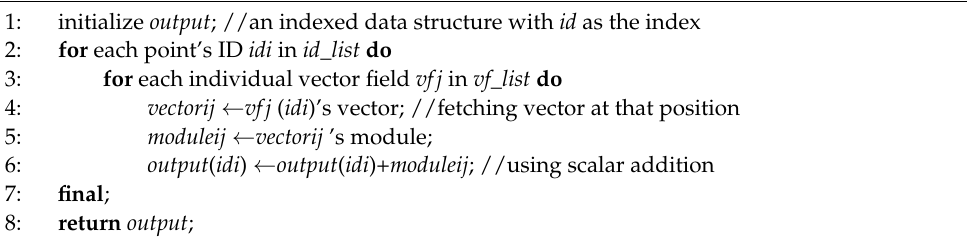
Algorithm 2: Build travel demand vector field for population (or specific